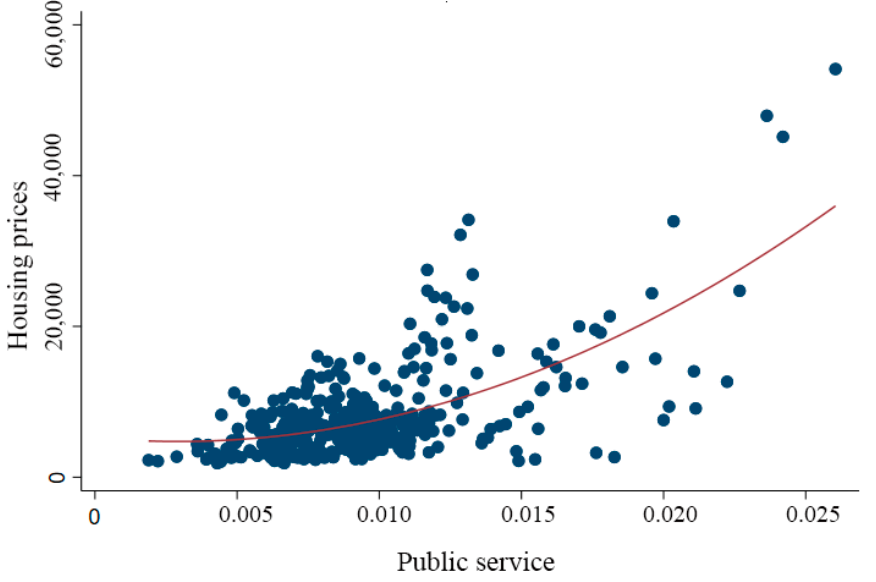
Figure 1. Nonlinear scattered fitting of public service to housing price level.